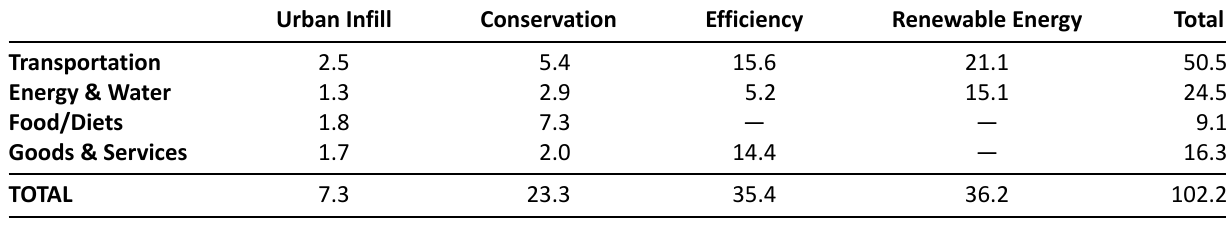
e) by carbon footprint category and intervention 2